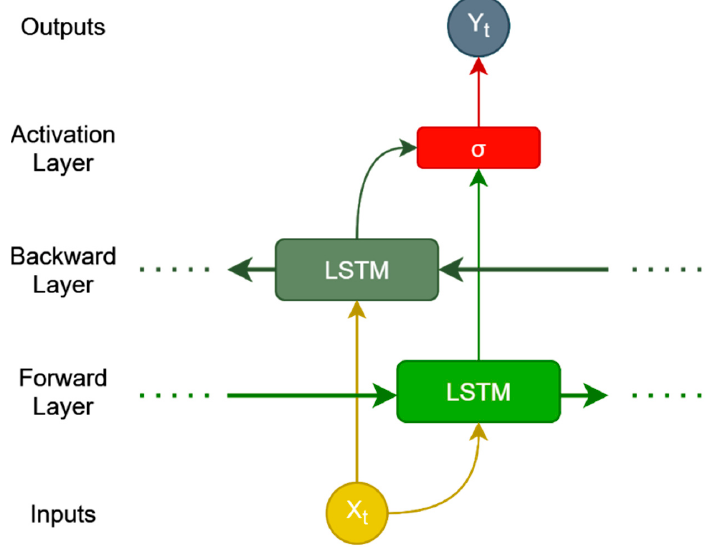
Figure 5. Bidirectional LSTM (Bi-LSTM)